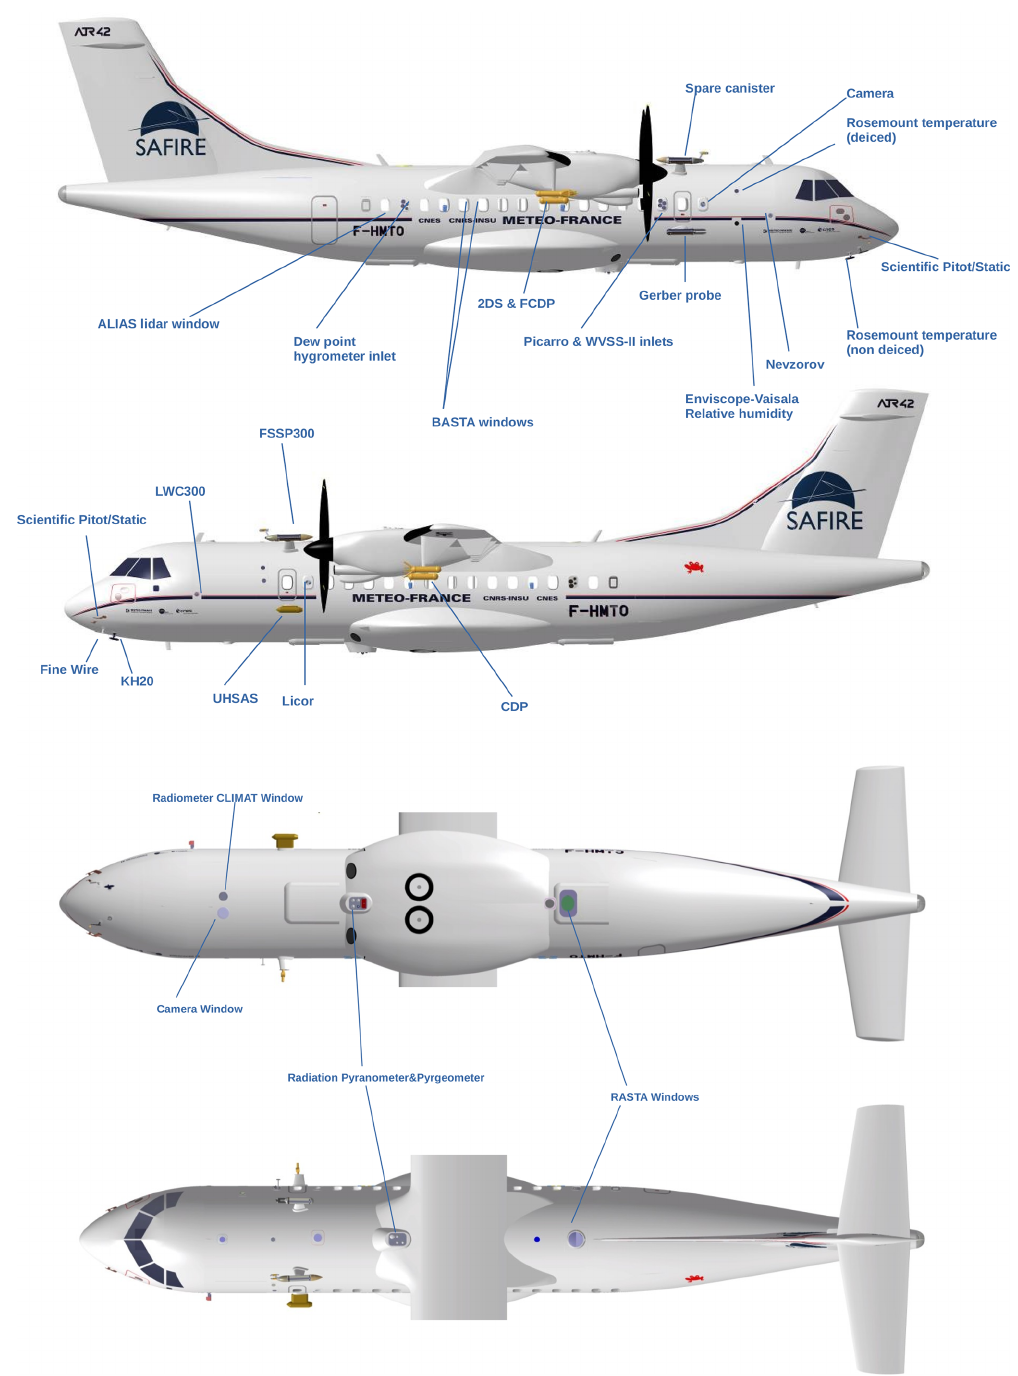
Figure 7. Location on the ATR of the main instruments discussed in this paper. The panels show the aircraft from different viewpoints: right, left, bottom and top, respectively. The exact positions of each instrument are given in Tables 5 to 9. Note that the Gerber, Nevzorov, FSSP300 and FCDP probes are not used in the EUREC 4 A datasets presented in this